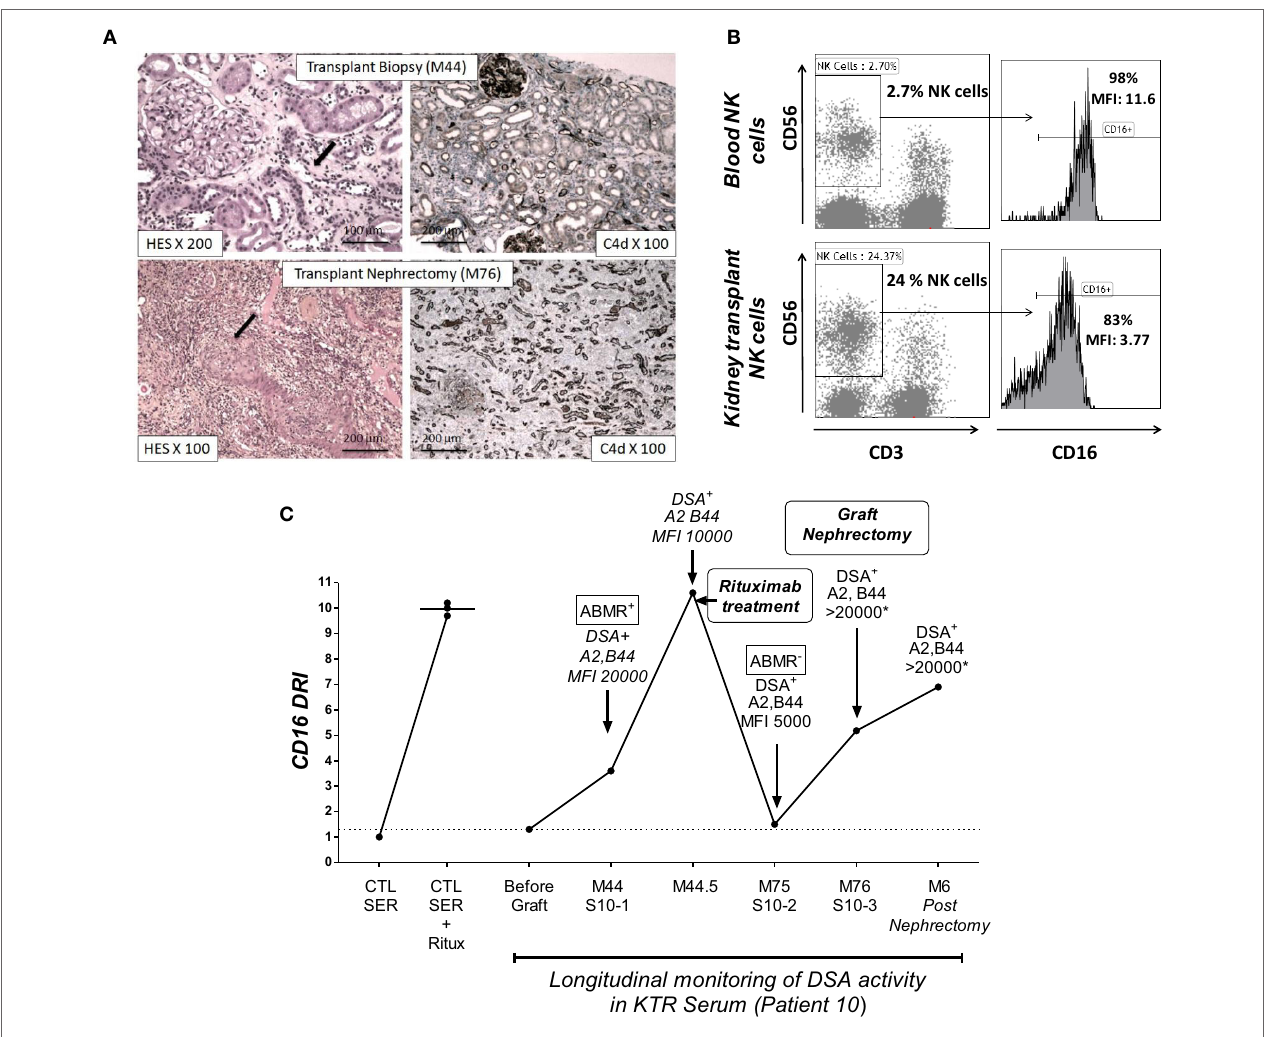
FigUre 5 | The nK-chaT monitoring of Dsa reactivity and characterization of cD16 engagement of nK cells infiltrating a kidney transplant site . (a) Histological assessment of lesions from biopsies of patient 10 at M44 and M76 (transplant nephrectomy). The M44 histological analysis showed peritubular capillaritis (cpt = 2, black arrow). At M76, histology revealed arteritis (v = 2, black arrow) and confirmed severe acute inflammatory lesions (t = 3, i = 3, g = 3, ptc = 3, v = 2, C4d = 3) with diffuse interstitial edema and chronic vascular lesions (cv = 2) as well as tubular atrophy (ct = 2). The left and right panels show the hematoxylin–eosin–saffron (HES) and C4d immunochemical staining of paraffin sections, respectively. (B) The NK-CHAT activity of five sera samples obtained during the longitudinal monitoring of patient 10 was analyzed in reference to serum obtained before transplantation (no sensitization). A significant increase in CD16DRI was concomitant with the detection of HLA-A2 and anti-B44 dn DSA at M44 as well as histological lesions of ABMR. The CD16DRI level decreased after rituximab treatment. The detection of low levels of circulating DSAs at M75 (before graft nephrectomy) was associated with a lowered CD16DRI and no evidence of humoral activity within the biopsy. An increased CD16DRI was observed at the time of graft nephrectomy and persisted for 6 months. At these two time points (M76 and 6 months after graft nephrectomy), the circulating DSA were at saturating titers, which did not allow accurate MFI quantification. (c) Comparative flow cytometric analysis of CD16 expression in blood CD3 − CD56 + NK cells and infiltrating NK cells isolated from the transplant after